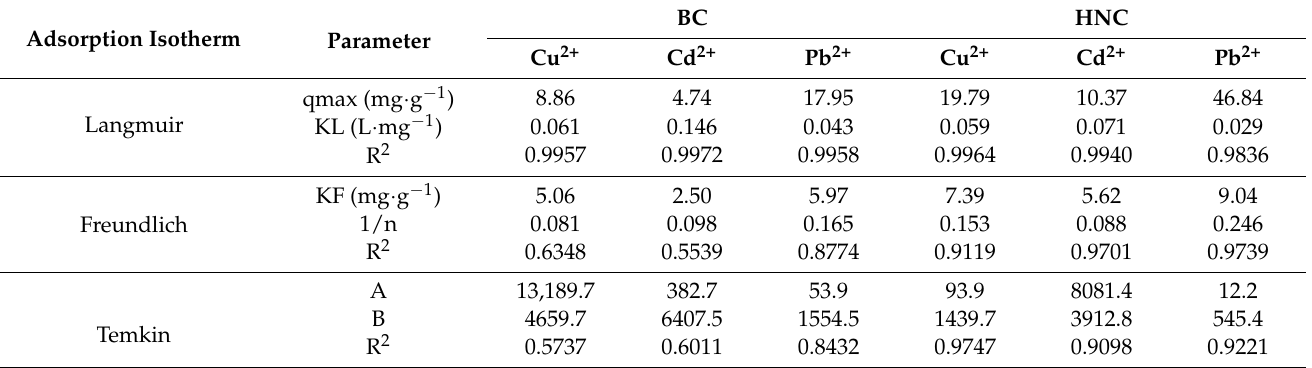
Figure 6. Equilibrium adsorption isotherms of metals by BC and HNC in a ternary system; dosage of 2 g/L, pH of 5.5, time of 240 min and temperature of 298.15 K (Langmuir ( a ), Freundlich ( b ) and Temkin ( c )). Table 3. Isotherm parameters of Langmuir, Freundlich and Temkin models for Cu 2+ , Cd 2+ and Pb 2+ by BC and HNC in a ternary